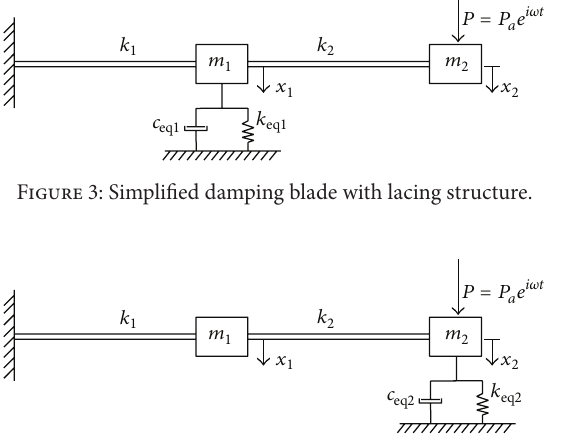
Figure 4: Simplified damping blade with shroud